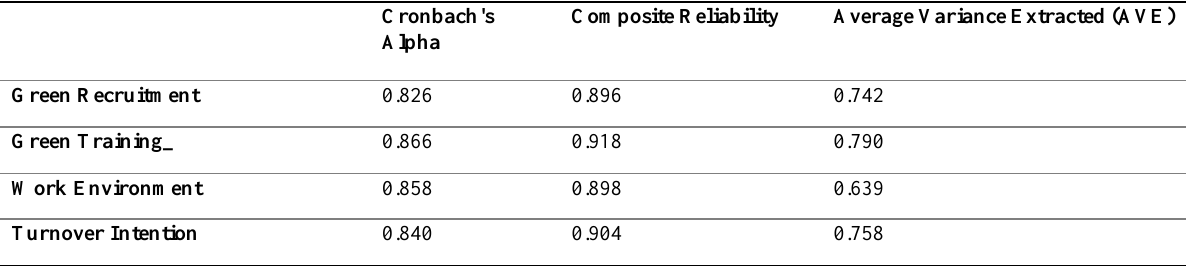
Table 4: Construct Reliability Test Results